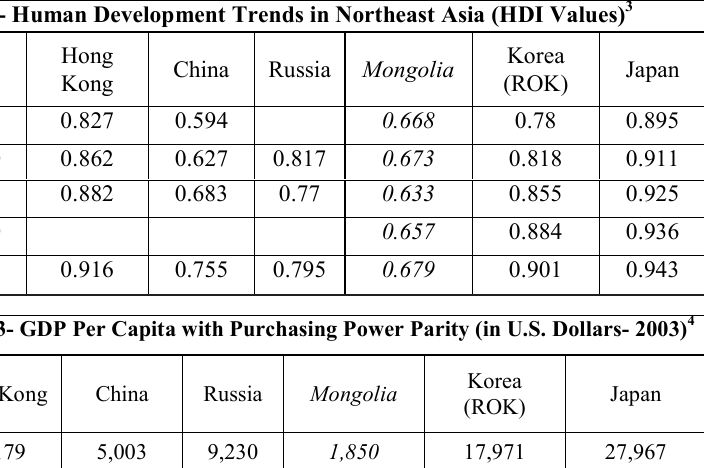
Fig. 2- Human Development Trends in Northeast Asia (HDI Values) 3